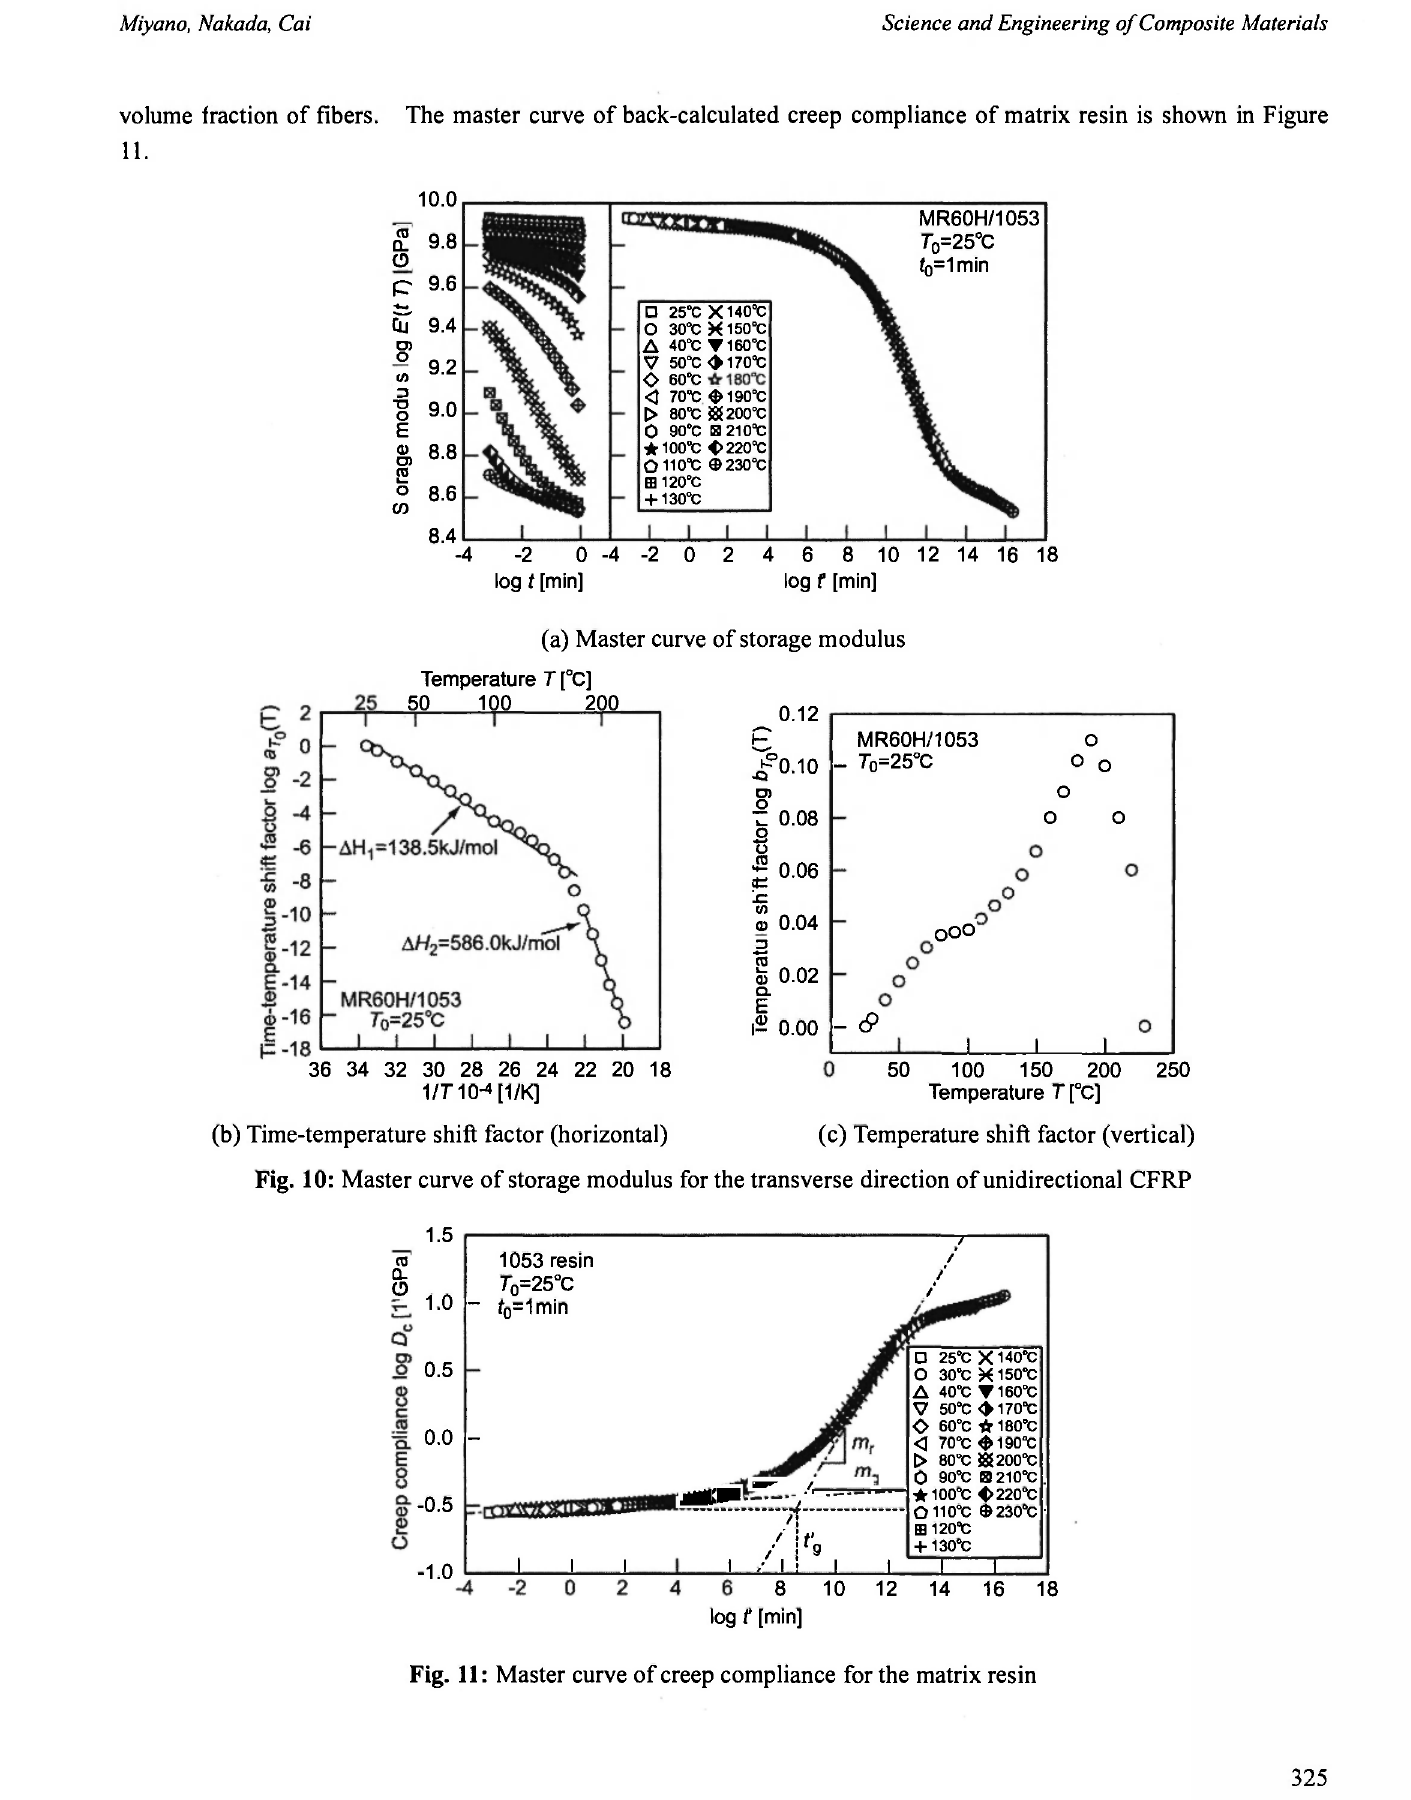
Fig. 10: Master curve of storage modulus for the transverse direction of unidirectional CFRP